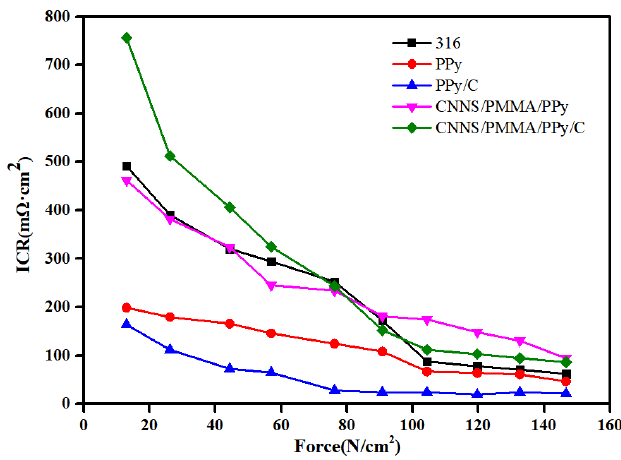
Figure 7. Contact angle of di ff erent interfaces: 316SS, pPy/C, CNNS/PMMA/pPy/C, and CNNS/PMMA. Interfacial contact resistance (ICR) of di ff erent samples.